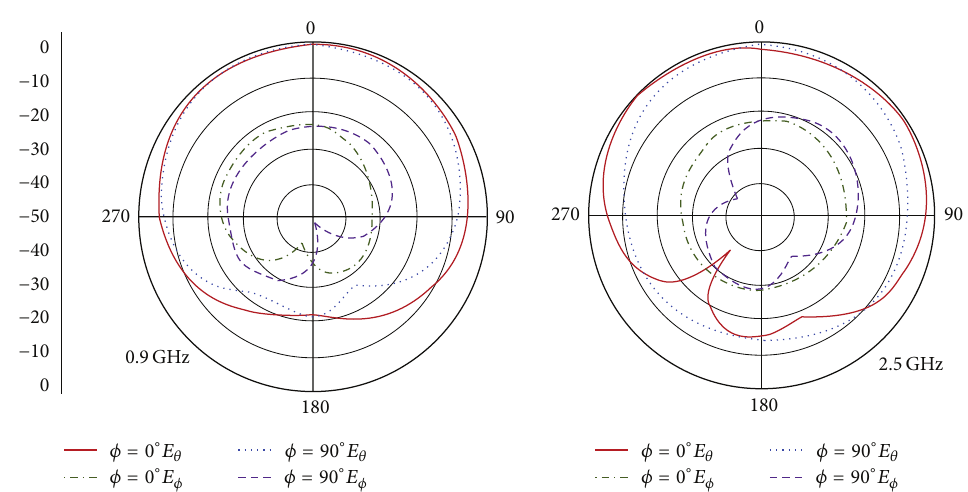
Figure 7: Radiation pattern for the proposed antenna for 0.9 GHz and 2.5